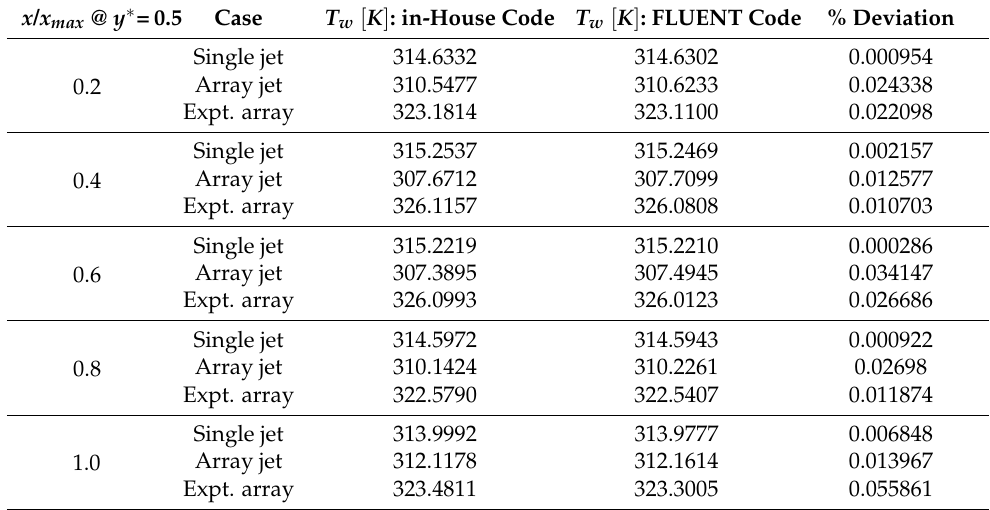
Table 2. Comparison of surface temperature calculations at selected locations, as predicted by in-house code and FLUENT